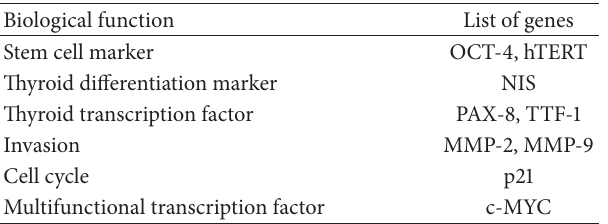
Table 2: List of genes that were used and categorized based on their biological